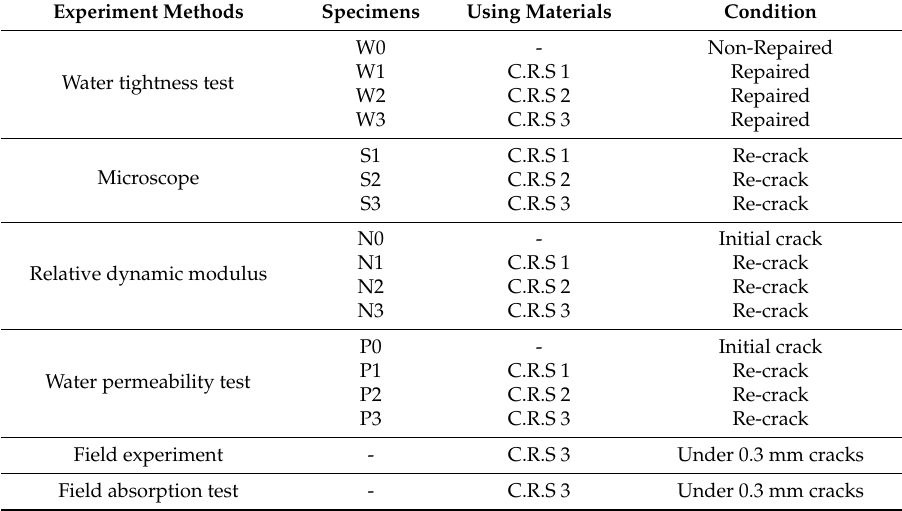
Table 2. Experimental details.